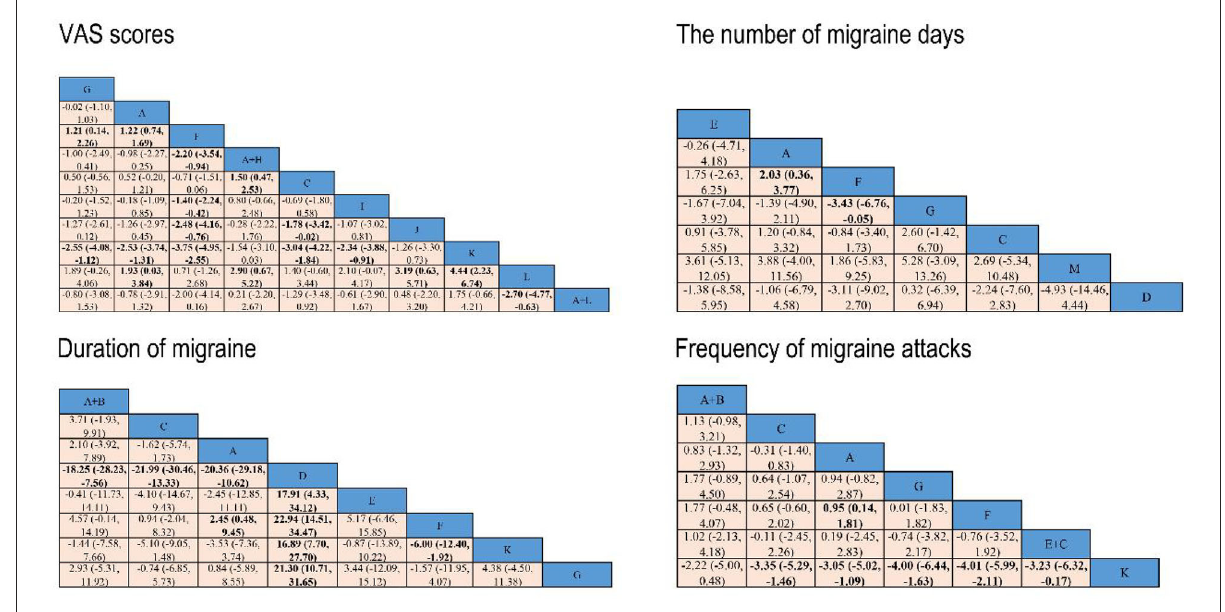
FIGURE5 Network meta-analysis results for VAS scores, the number of migraine days, duration of migraine, and frequency of migraine attacks. Significant results are bolded in black. A, conventional acupuncture; B, massage; C, analgesic; D, embedding needle therapy; E, acupressure; F, placebo; G, electroacupuncture; H, cupping; I, auricular acupuncture; J, acupoint implantation; K, acupoint injection; L, traditional Chinese medicine; and M, laser acupuncture.